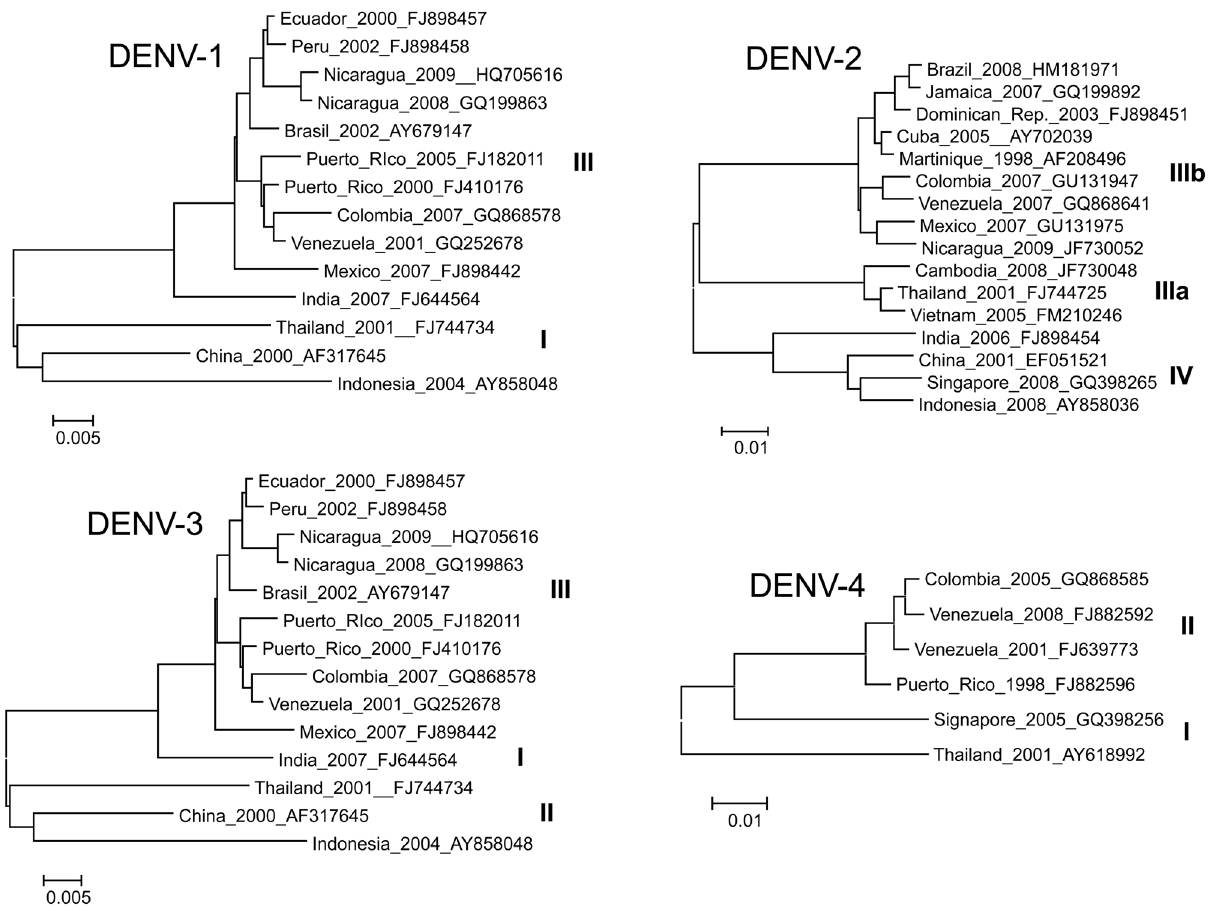
Figure 1. Maximum likelihood phylogeny of contemporary DENV strains. Representative DENV strains from currently circulating genotypes considered for primer and probe modifications. Full genome sequences were used. Each taxa is labeled: country of origin, year of isolation, and GenBank accession number. Due to figure space limitations, only a representative subset of strains were used to generate these ML trees. DENV-1 Asian (I) and American-African (III) genotypes [55], DENV-2 Asian I (IIIa), American-Asian (IIIb), and Cosmopolitan (IV) genotypes [42], DENV-3 South Pacific (I), Thailand (II), and Indian Subcontinent (III) genotypes [55,56], DENV-4 Southeast (I) and Indonesian (II) genotypes [56].